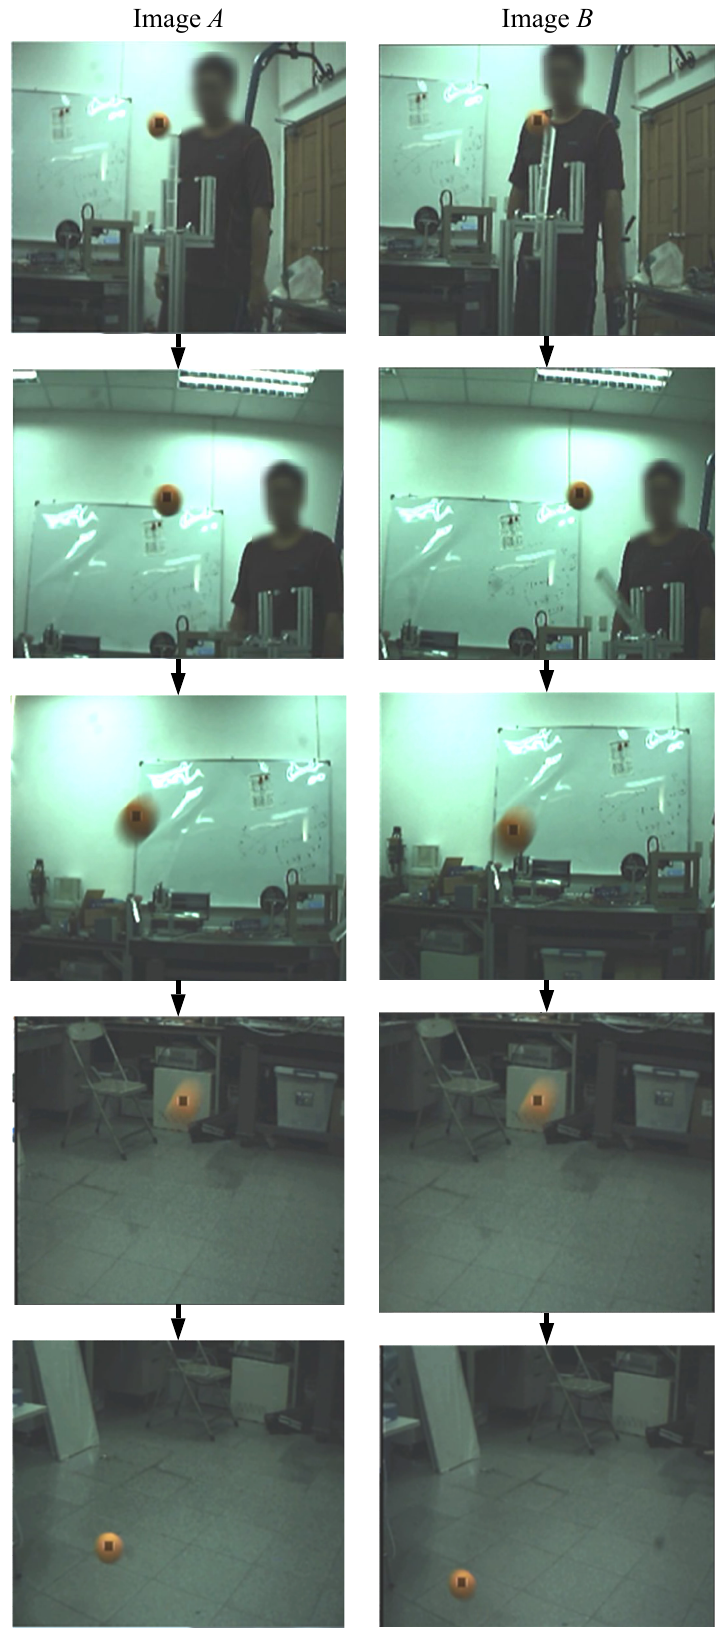
Figure 19. A flying ball: the sequence of images